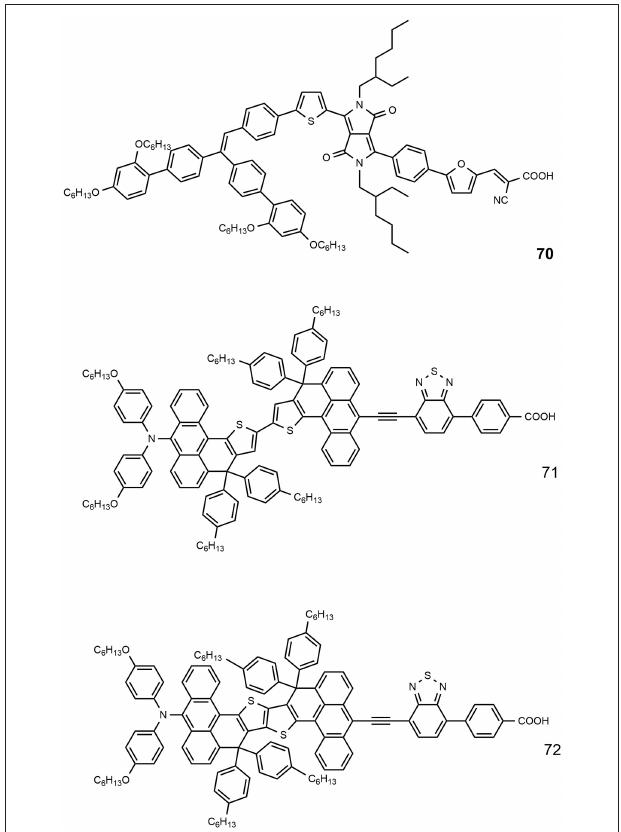
FIGURE 10 | Chemical structures of dyes 70–72.